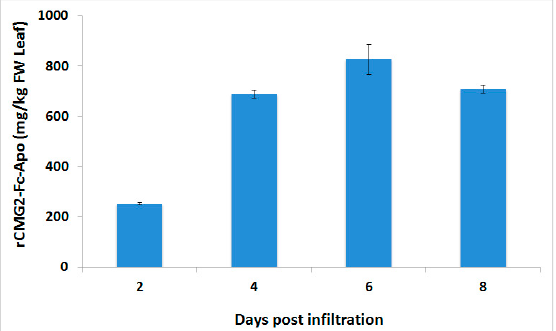
Figure 2. Production kinetics of rCMG2-Fc-Apo protein. Transient production of the rCMG2-Fc-Apo protein on a leaf fresh weight (FW) basis in Nicotiana benthamiana plants was measured by ELISA. The p19 gene silencing suppressor was co-expressed to improve the rCMG2-Fc-Apo protein expression. At different time points post-infiltration, entire leaves from an infiltrated plant batch (three plants/batch/data point) were cut at the petioles and harvested and rCMG2-Fc-Apo levels were determined from combined leaf biomass. Error bars were determined from propagation of standard errors calculated from triplicate technical assays performed.